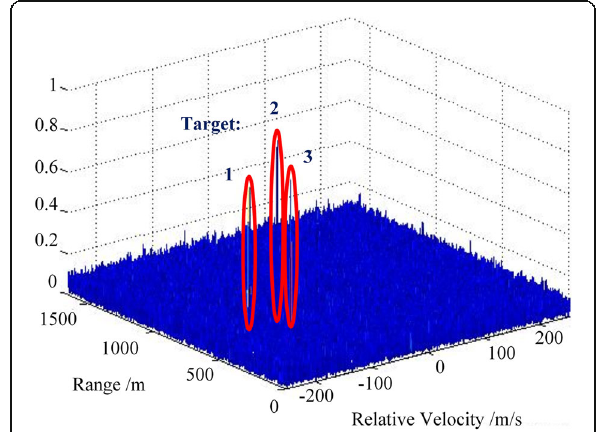
Fig. 8 The radar graph of CE-OFDM RadCom system for three targets